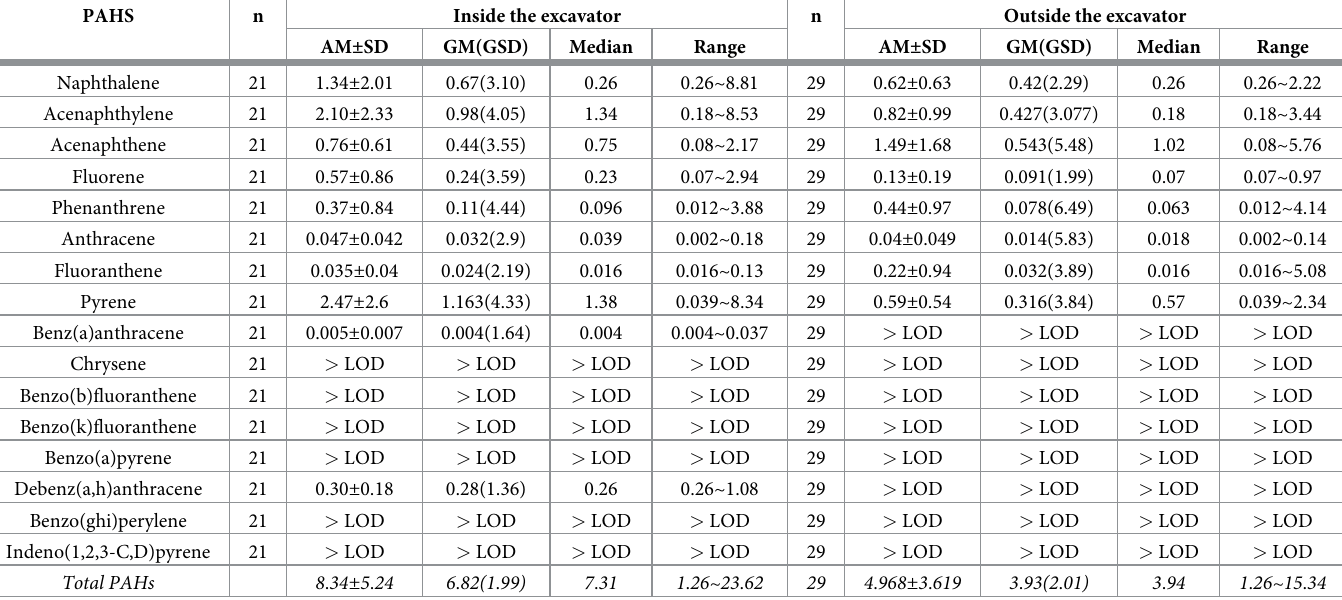
Table 4. Comparison of PAHs concentration between inside and outside of the excavator (unit: μ g/m 3 ). PAHS n Inside the excavator n